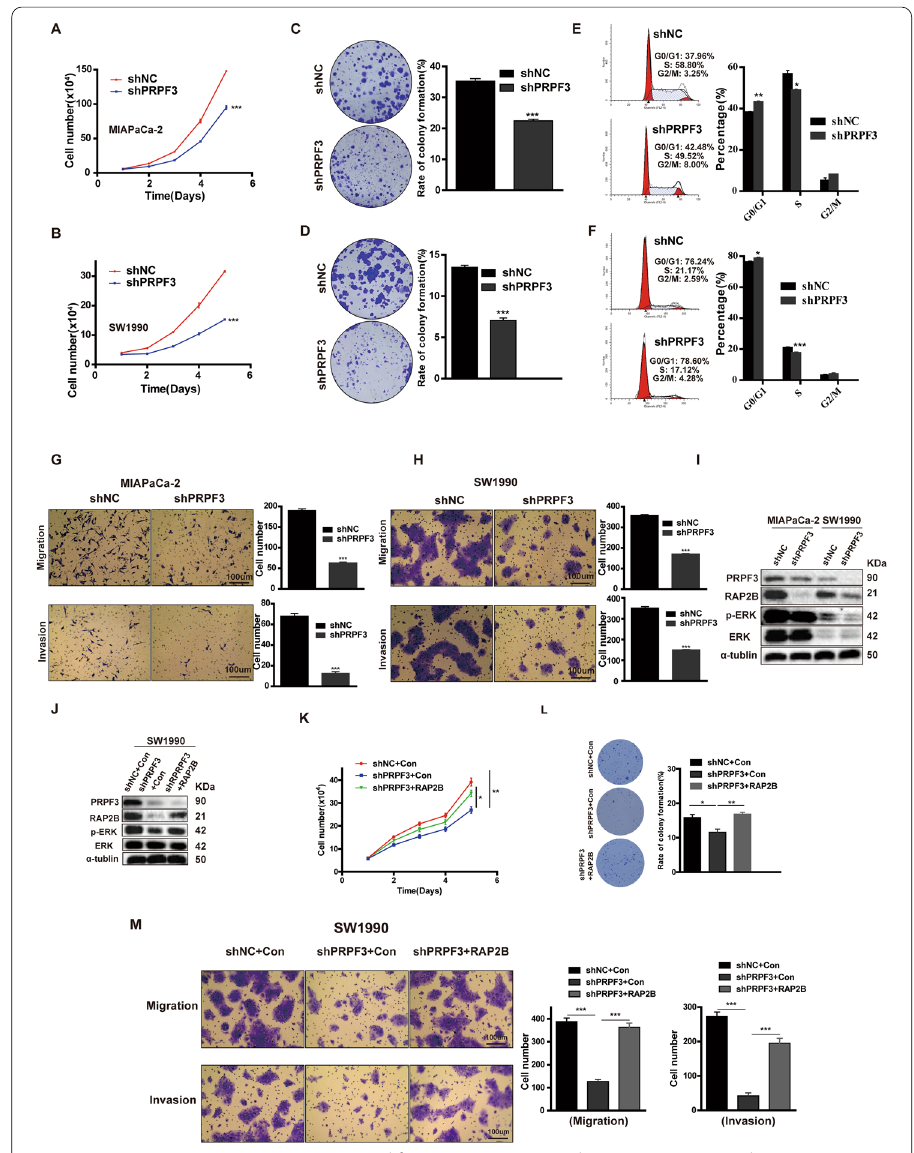
Fig.5 PRPF3 promotes pancreatic cancer proliferation, migration, and invasion in vitro via the RAP2B/ ERK pathway. A , B Cell counting assays showed the effect of PRPF3 on pancreatic cancer cells proliferation in MIAPaCa-2 A and SW1990 B cells. C , D Colony formation assays were performed in MIAPaCa-2 ( C ) and SW1990 D cells. E , F The effect of PRPF3 on the cell cycle in MIAPaCa-2 ( E ) and SW1990 F cells were detected. G , H transwell assays were performed to detect the migration and invasion abilities of PRPF3-silenced MIAPaCa-2, and SW1990 cells and control cells. I The indicated protein expression levels in PRPF3-knockdown MIAPaCa-2, SW1990 cells, and control cells were detected. J Western blot results showing the indicated protein expression levels in SW1990 cells stably transfected with control, shPRPF3, and shPRPF3 RAP2B. + K – M Cell counting, colony formation, and transwell assays showing that the suppression of proliferation, migration, and invasion by shPRPF3 in SW1990 cells was partially abolished by RAP2B. Scale bar 100 μm. = Results are shown as the mean SD of three independent replicates. * p < 0.05, ** p < 0.01, *** p < ±